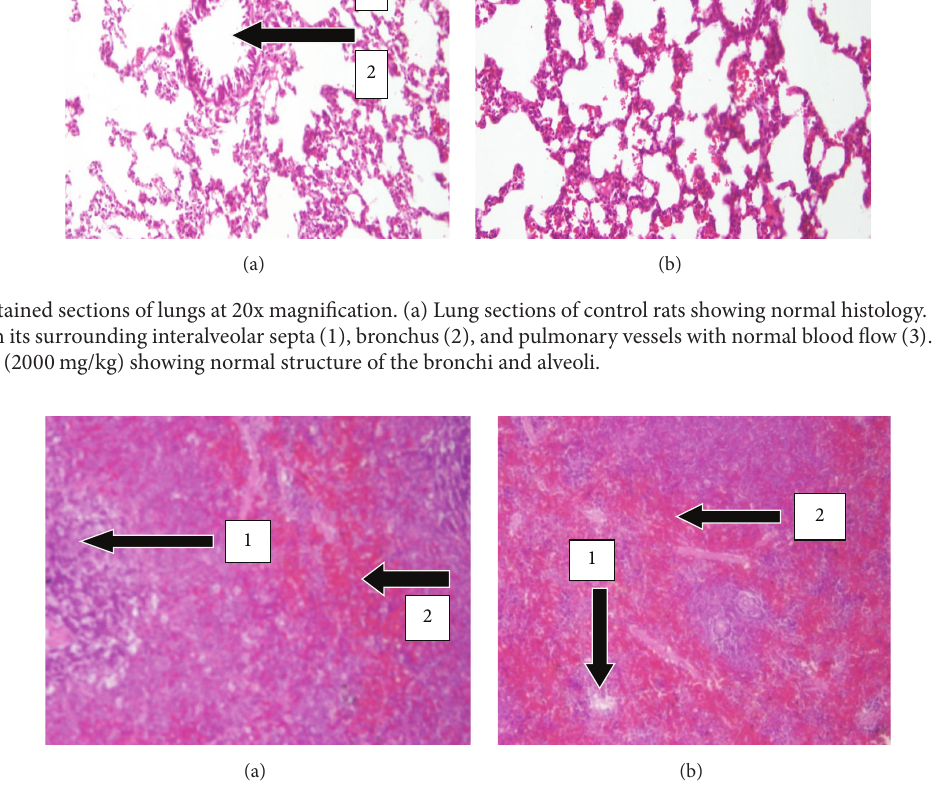
Figure 6: H&E stained sections of the spleen at 20x magnification. (a) Spleen sections of control SD rats showing normal histology. Note the presence of the white pulp (1) and the red pulp (2) . (b) Spleen sections of treated male SD rats (2000 mg/kg) of UNCP showing intact splenic